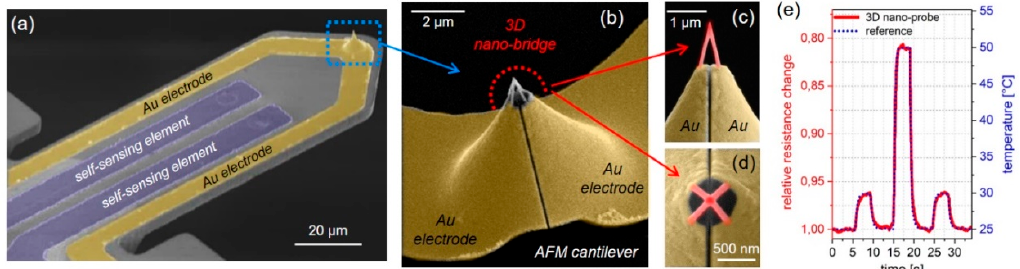
Figure 10. FEBID-based 3D nano-probes for localized thermal sensing. ( a ) shows the self-sensing cantilever platform (copyright GETec Microscopy, Austria [95]), where sensing elements and pre-structured Au electrodes are indicated blue and yellow, respectively. ( b ) shows an SEM image of the tip region, in which the truncated, pre-existing tip, the split electrodes, and the 3D nano-bridge are evident. The latter is shown in higher magnification in a side ( c ) and top view ( d ), where the 3D nano-bridge is shown in red. Once in contact with the sample surface, the small active volumes of the 3D structure allow a fast response, as shown in a dynamic response test in ( e ) by the red curve in comparison to the reference temperature (blue). A sensing rate better than 30 ms/K with a noise level below ±0.5 K could be demonstrated, which exhibits the advantages of 3D-FEBID nano-structures for advanced AFM concepts, applicable on even pre-finished micro-cantilever. Adapted and reprinted from Sattelkow et al., Appl. Mater. Interfaces 2019 [66].